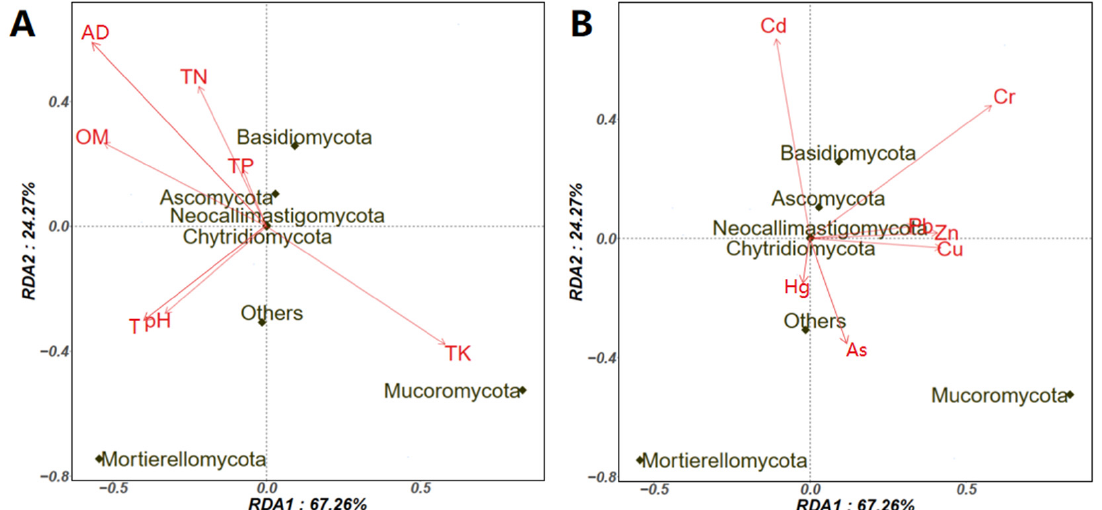
Figure 7. Factors involved in the aerosolization behavior of fungal phylum using redundancy anal- ysis (RDA). ( A ), physicochemical parameters on log BI of fungal phylum; ( B ), Specific heavy metals on log BI of the fungal phylum. OM, Organic matter; AD, air-dried moisture; TN, Total nitrogen; TK, Total potassium; TP, Total phosphorus; OM, The organic matter; AD, Air-dried moisture; T, Temperature.